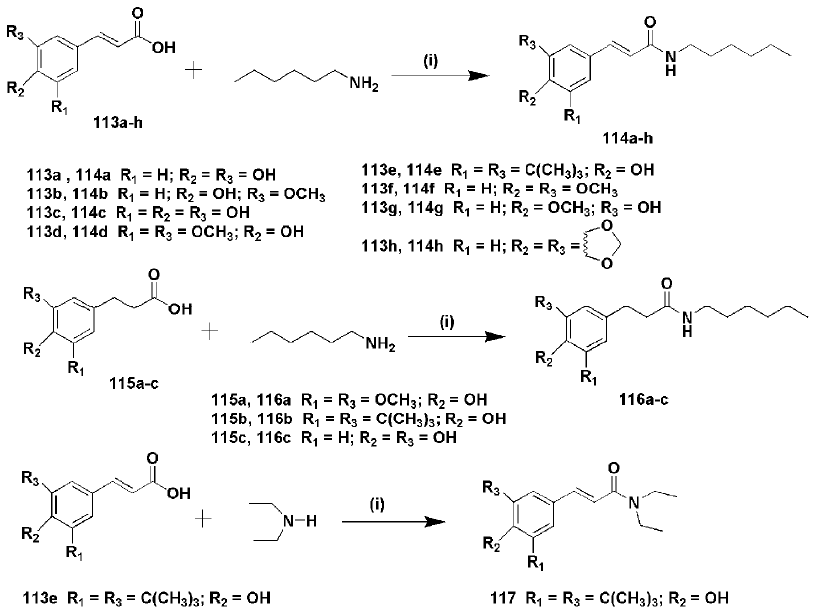
phosphonium hexafluorophosphate(BOP), Dichloromethane (DCM), room temperature (rt) [82].